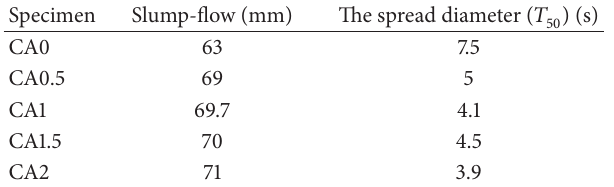
Figure 3: Ratio of ℎ 2 /ℎ 1 in L-box test. Table 5: Results of slump-flow test.